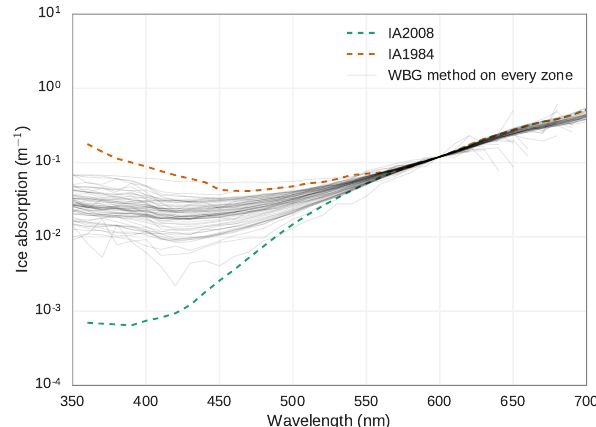
Figure 5. Seventy ice absorption spectra estimated by the WBG method (Warren et al., 2006) on each homogeneous zone from the selection on the 56 radiance profiles measured around